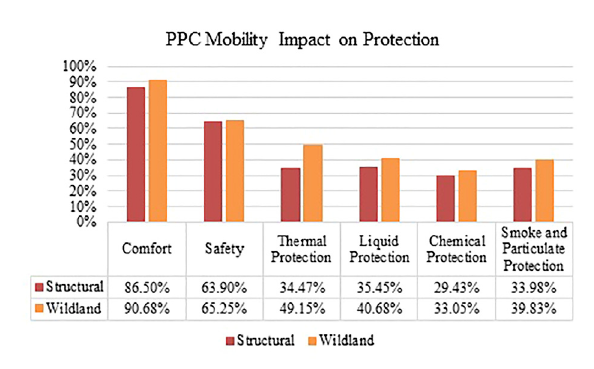
FIGURE 3 Percentage of female fi re fi ghters perceiving an impact on their protection from improperly fi tted PPC.